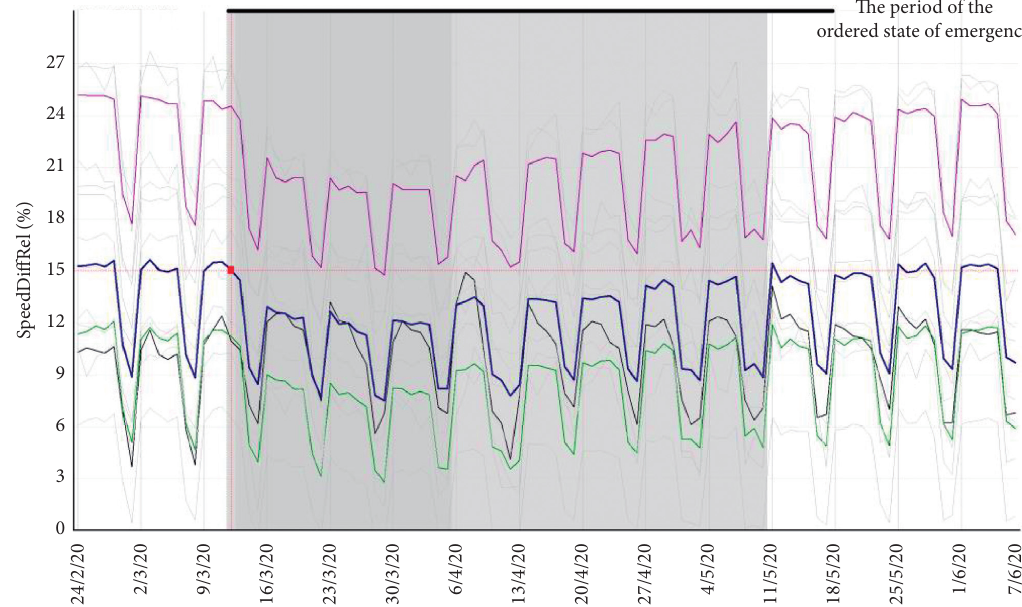
Figure 3: Average hourly relative deviation from FreeFlowSpeed. Motorways are highlighted in black, 1 st class roads are violet, and residential area roads are